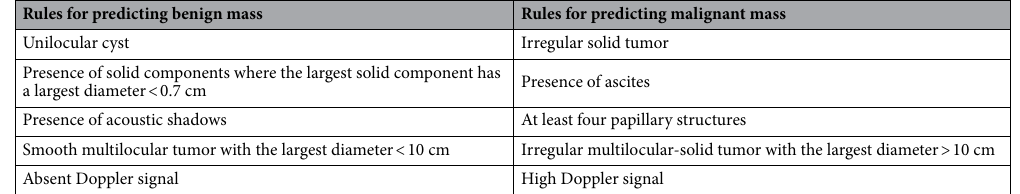
Table 1. IOTA simple rules assessment. In this protocol, if one or more benign features are found in the absence of any malignant features then the tumor is defined as benign. If one or more malignant features are found in the absence of any benign features, then the tumor is defined as malignant. If no features are seen or if both malignant and benign features are observed then the tumor is unclassified or indeterminate 3–5,10